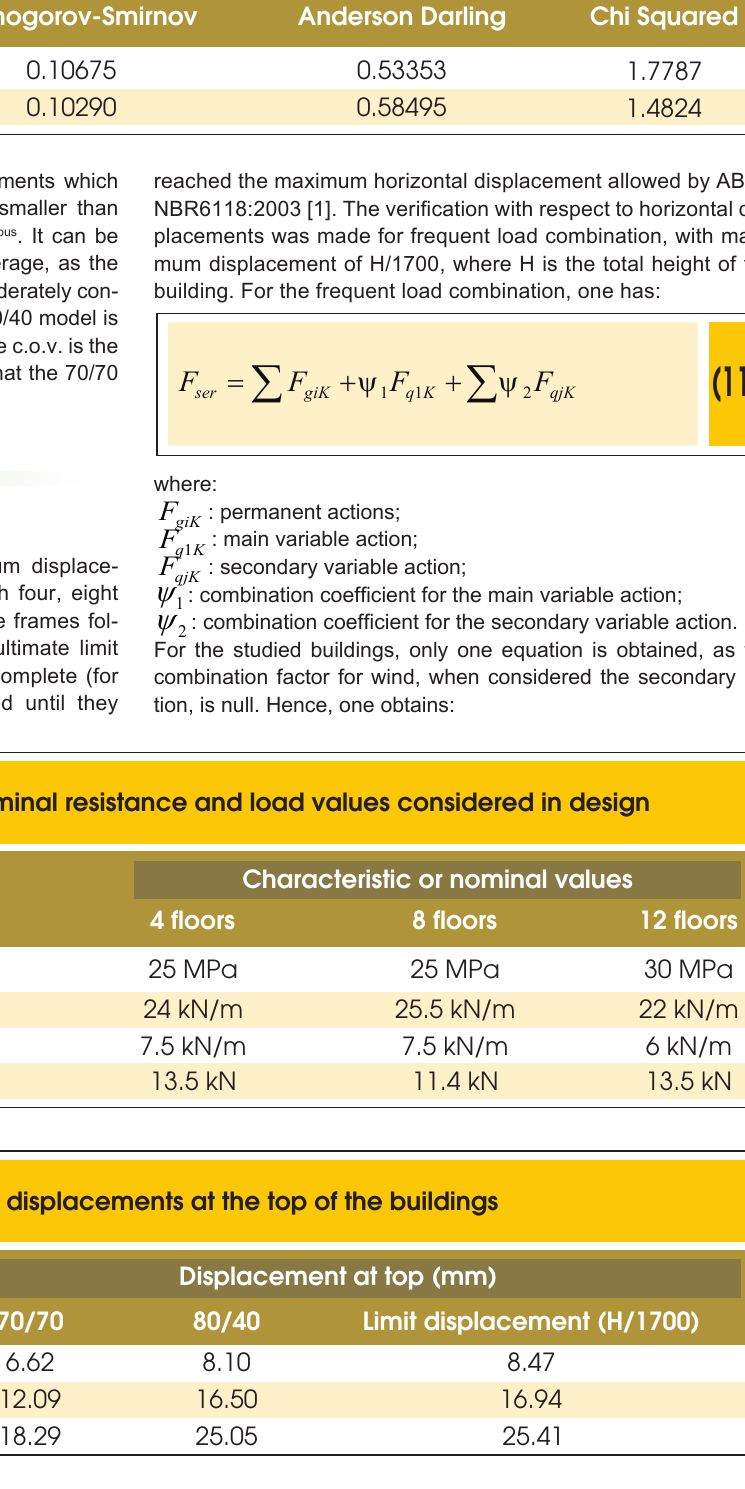
Table 2 – Statistics of goodness-of-fit tests for the Normal distribution Model